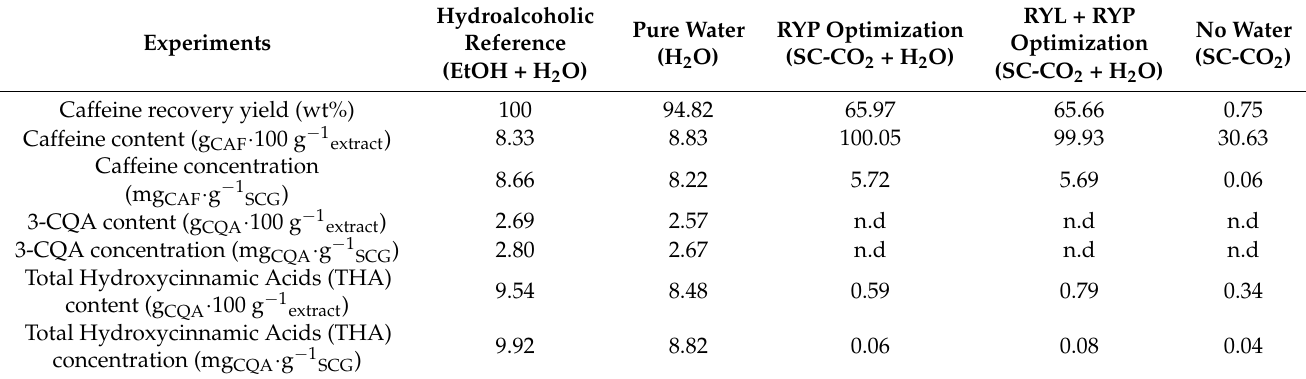
Table 8. Characterization of polar molecules fraction by amount extracted from SCG and content in the extract of Caffeine, 3-CaffeoylQuinic Acid (3-CQA) and Total Hydroxycinnamic Acids (THA) obtained with HPLC-DAD for our study experiments and in the